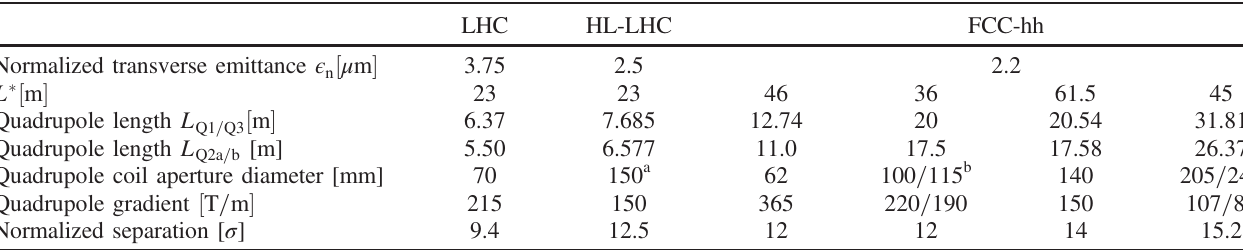
TABLE II. Parameters of the lattice